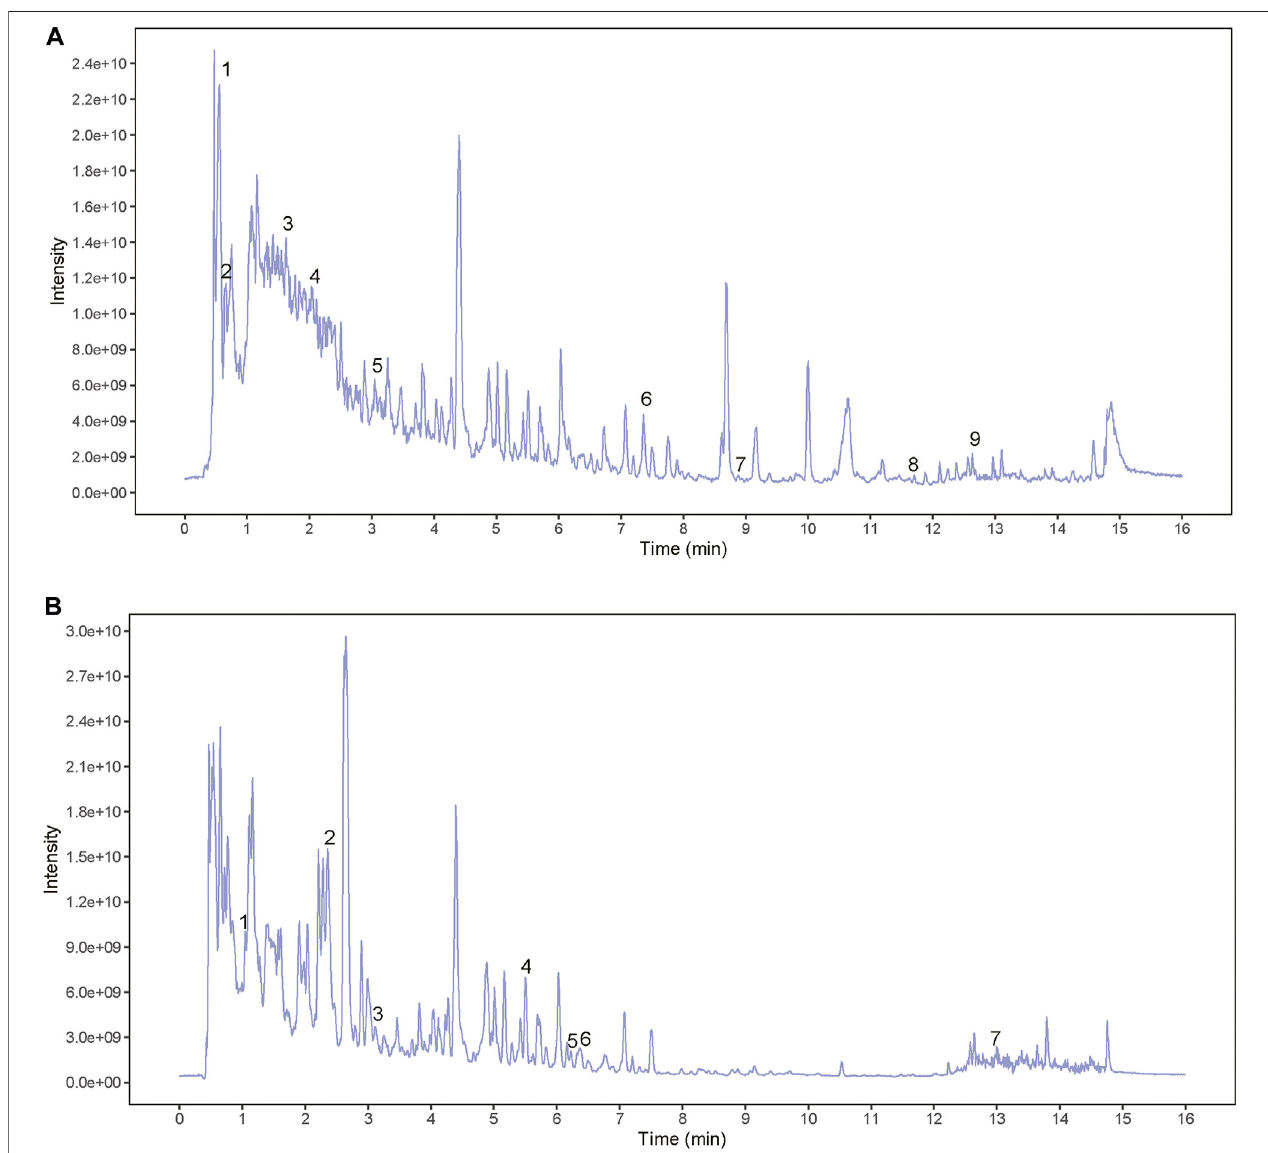
FIGURE 2 | The total positive and negative ion chromatograms of BSHXD. (A) The total positive ion chromatograms of BSHXD; (B) The total negative ion chromatograms of BSHXD.